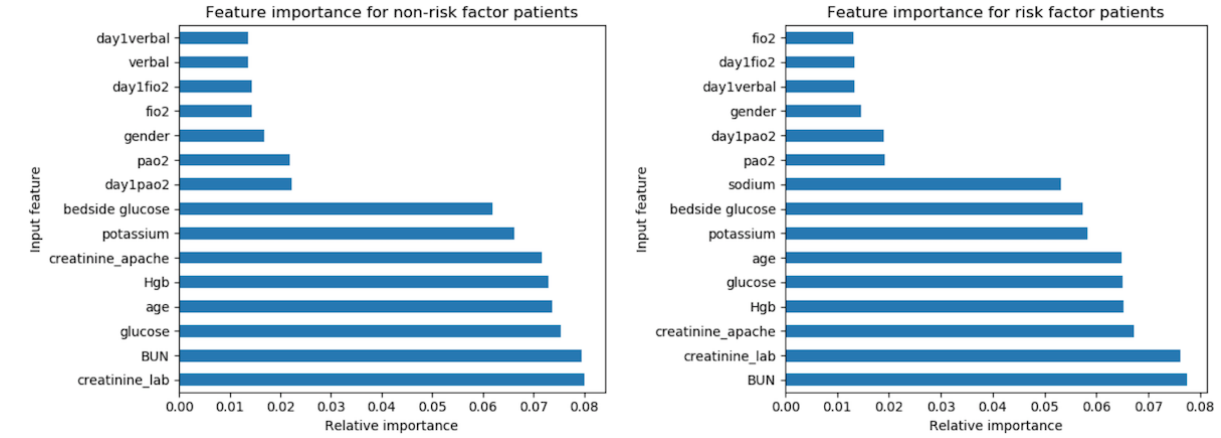
Figure 5. Random forest feature importance with 150 estimators for nonrisk factor and risk factor patients. BUN: blood urea